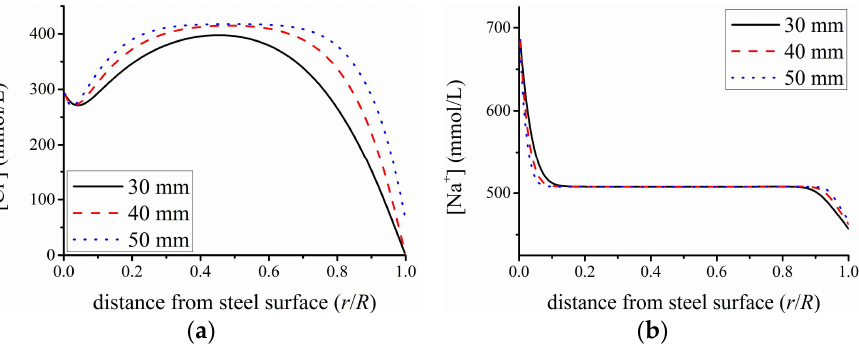
Figure 5. The concentration profiles of cations and anions within the concrete cover after 1 A/m 2 and 4 weeks of the electrochemical treatment ( a ) Cl − ; ( b ) Na +. Table 4. Mean ionic concentrations in the vicinity of steel after the electrochemical treatment of different cover thicknesses.